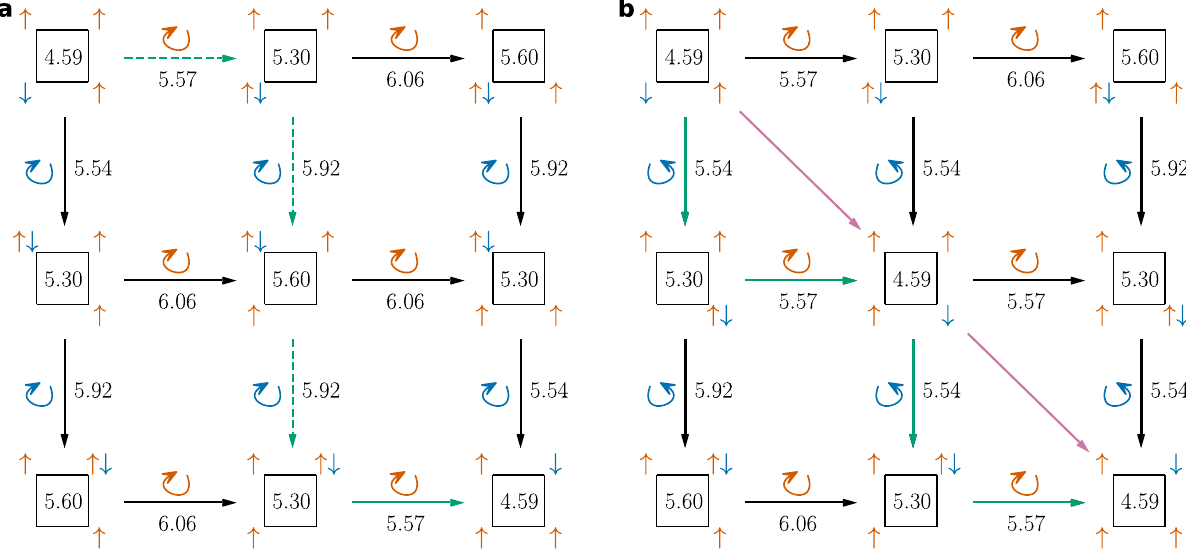
Fig. 7 Maximum probability paths for the π system of triplet CBD. Comparison of all possible paths with probabilistic potentials for SCPs and DCPs. Resulting in MPPs without restrictions (green) and restricted to covalent DCPs (purple). Spin-up and spin-down electrons rotate in a the same direction, b opposite